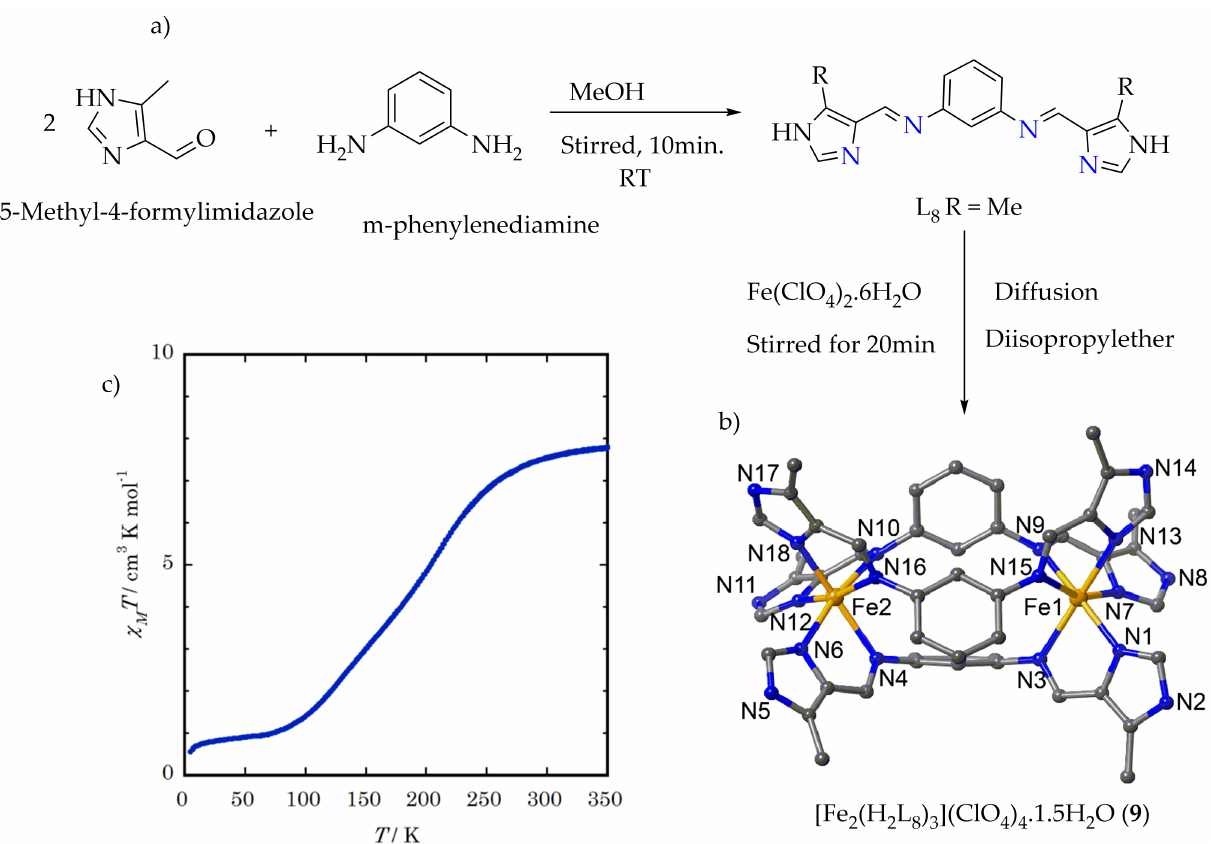
Figure 8. ( a ) Synthesis root of ligand L 8. ( b ) Crystal structure of the complex 9 .1.5H 2 O. ( c ) The χ M T vs. T plot of desolvated complex 9 . Reproduced with permission from [72] ; Published by Bulletin of the Chemical Society of Japan,